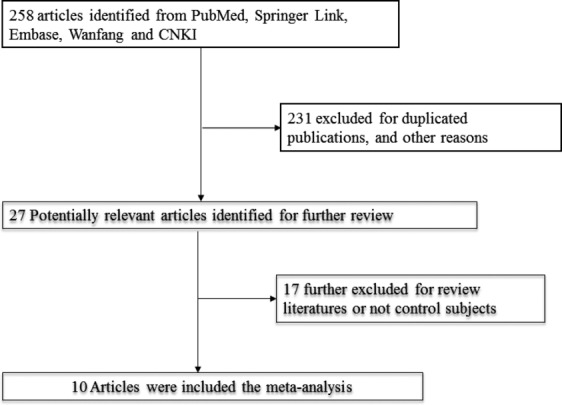
Flowchart of literatures identification.